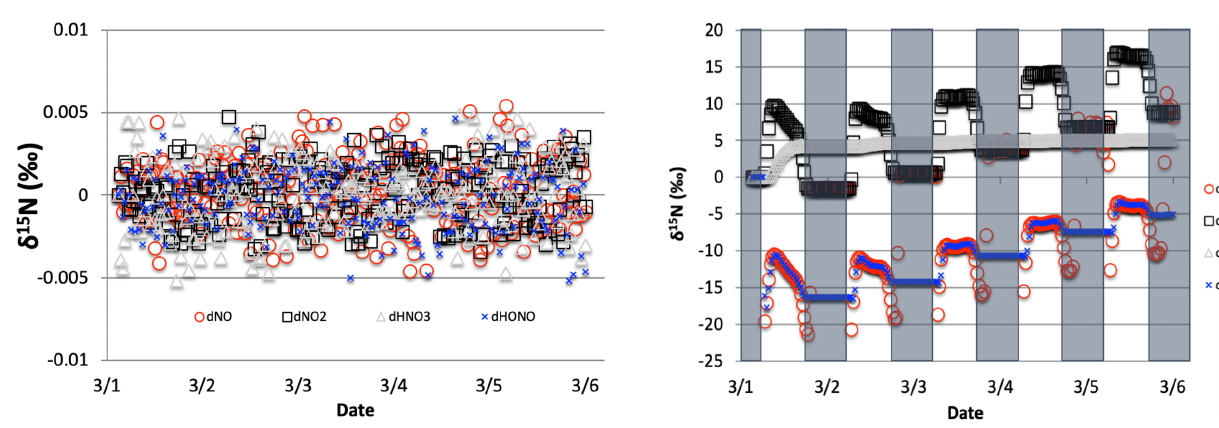
Figure 2. The time evolution of δ 15 N values of NO, NO 2 , HNO 3 , and HONO caused by PHIFE during NO 2